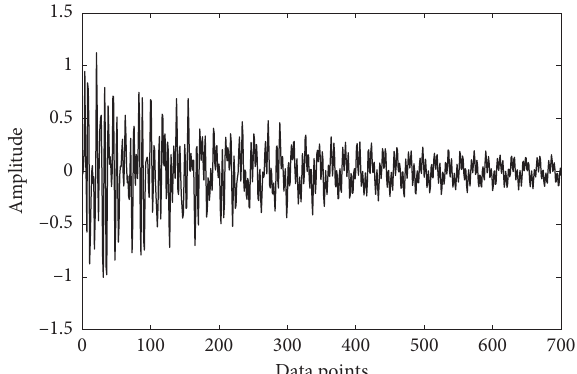
Figure 20: The distribution of identified frequency-damping with model order for damage case ① .